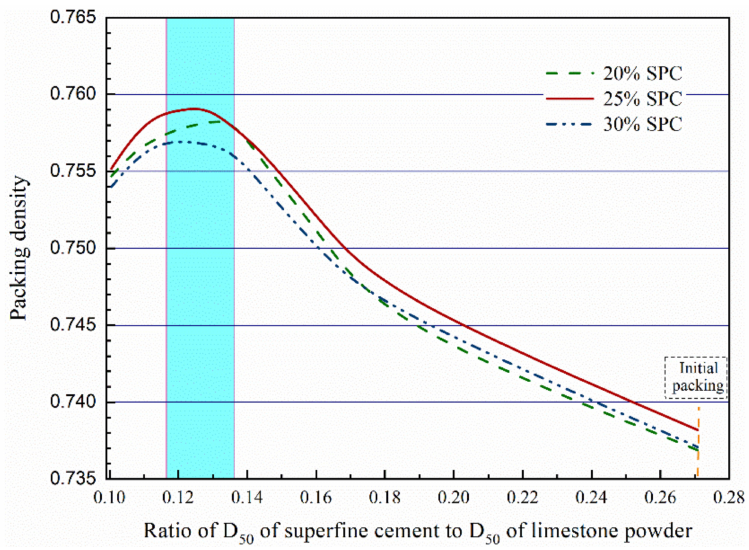
Figure 5. Effect of the D 50 ratio between superfine portland cement and limestone powder on the packing